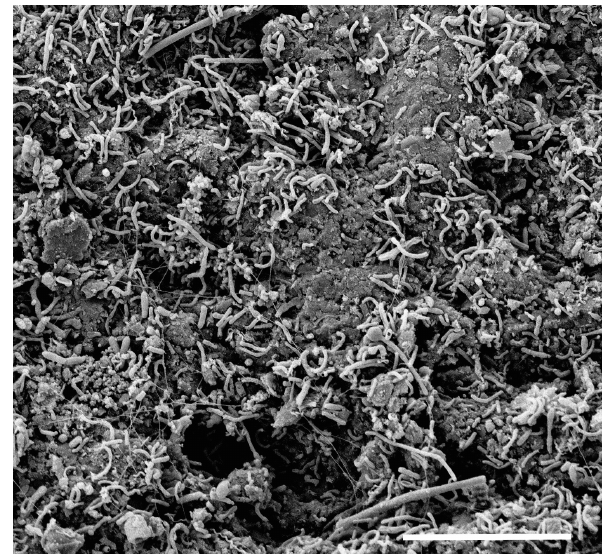
Figure 5. A scanning electron micrograph of an anaerobic, methanogenic microbial community enriched in ∼ 2km deep sub- seafloor coal samples. The cultivation experiment was carried out using a continuous-flow bioreactor at 40 ◦ C for 694 days. Bar: 10µm. (Photo: Hiroyuki Imachi,